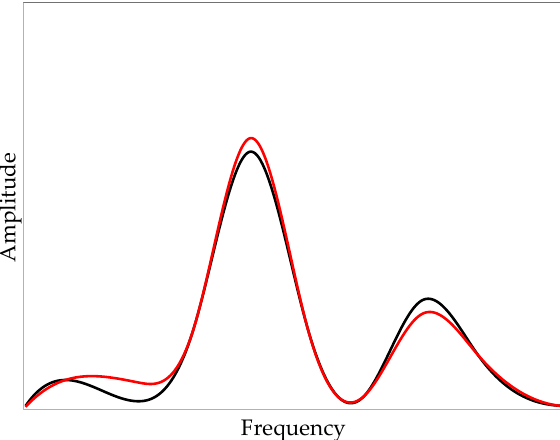
Figure 2. Hypothetical spectrum of o ff -bridge (black) and on-bridge (red) acceleration